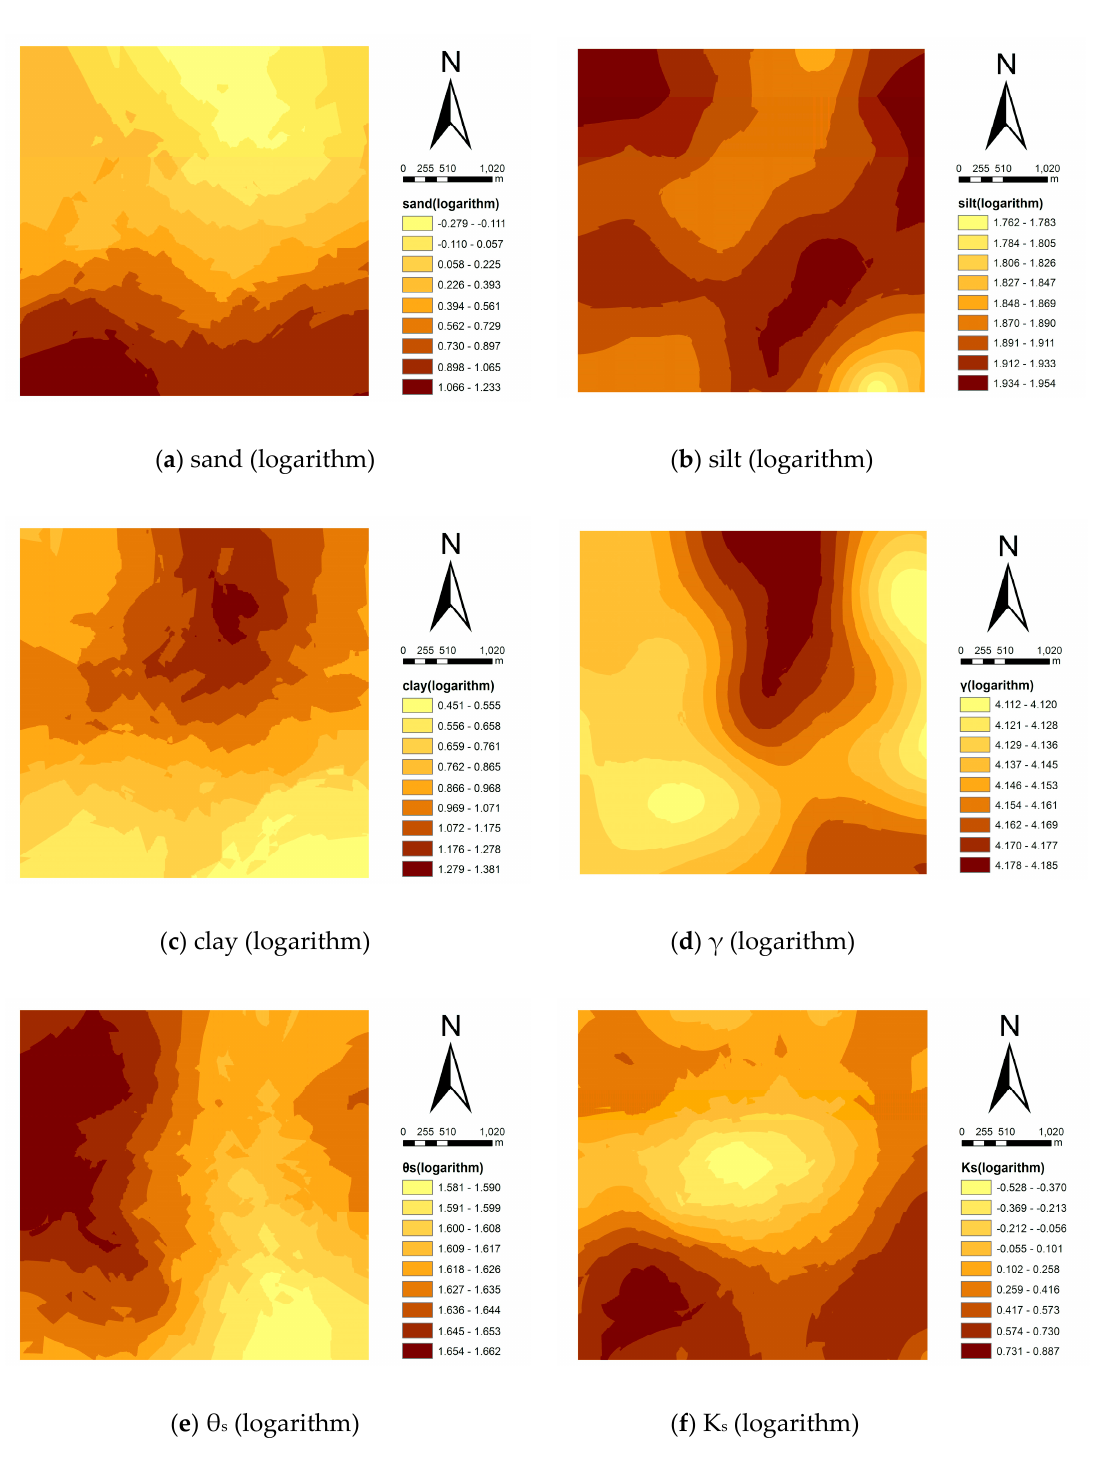
Figure 3. Kriging interpolation maps of soil properties.